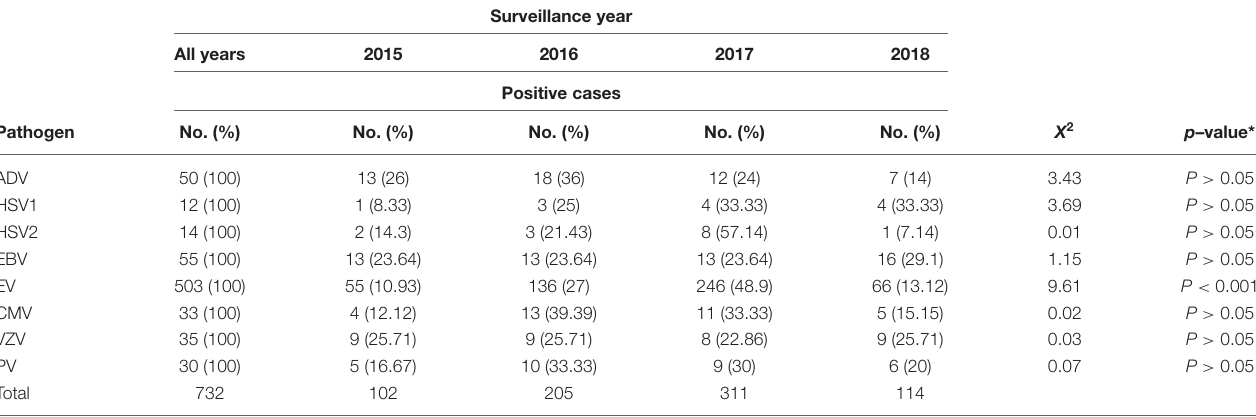
TABLE 2 | Distribution of different VM pathogens by year of